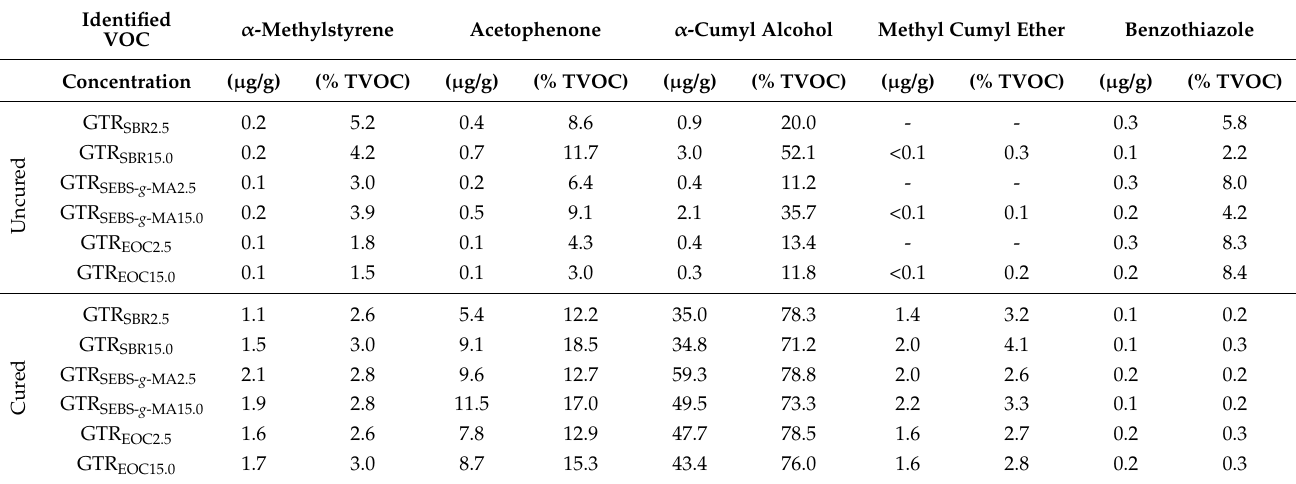
Table 9. Concentration of the most significant VOCs identified for uncured and cured materials by micro-chamber/thermal extractor